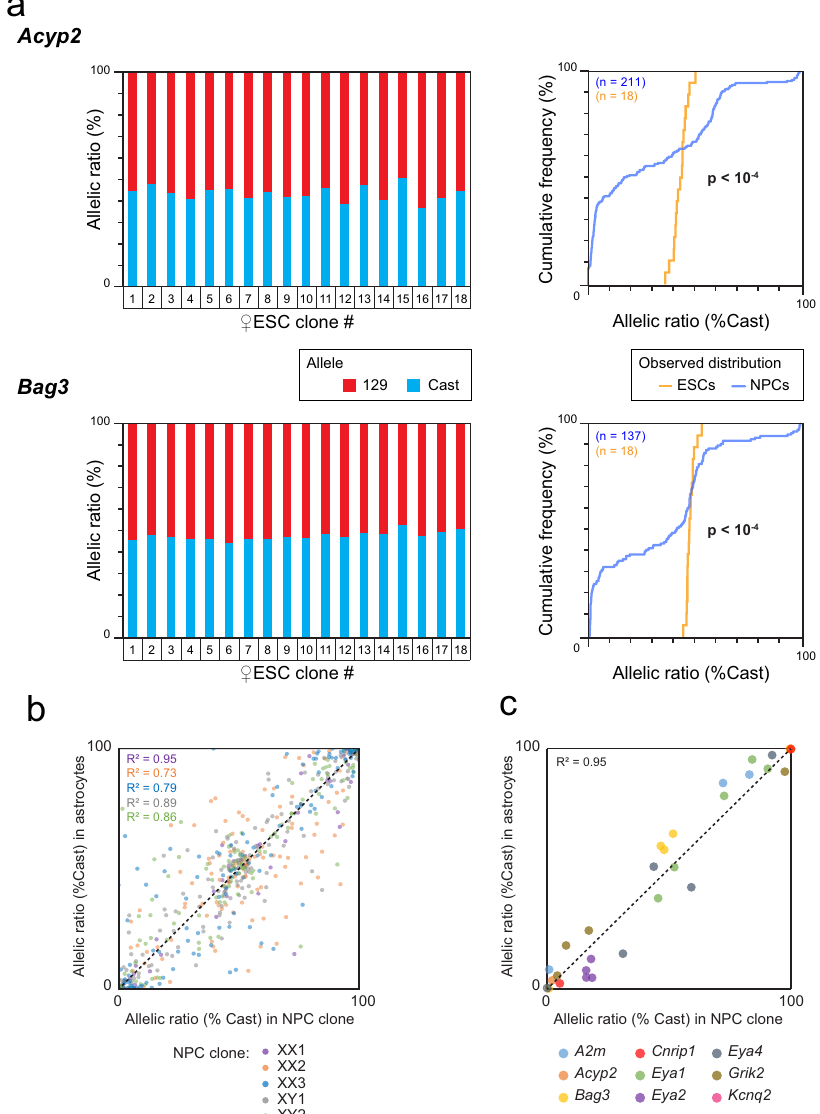
Fig. 3 Allele-speci fi c expression is established during differentiation and then maintained. a Analysis by RT-PCR followed by pyrosequencing of Acyp2 and Bag3 allelic expression ratio in 18 clones generated from the F1-21.6 ESC line (left panels). Comparison of the cumulative distributions of allelic expression ratios in ESCs and NPCs (Kolmogorov – Smirnov tests, right panels). n is the number of clones analyzed. b Comparison of the allelic expression ratios of the genes previously categorised as RME in NPCs 11 and after differentiation into astrocytes, for fi ve NPC clones, measured by allele-speci fi c RNA- seq. The number of assessable genes per clone (values with less than 20 reads were excluded) is n XX1 = 75, n XX2 = 146, n XX3 = 121, n XY1 = 150, n XY2 = 137. Pearson correlation coef fi cients were calculated for each NPC clone. c Comparison of the allelic expression ratio for the nine genes, which showed several modalities of expression, in fi ve NPC clones and after differentiation into RME genes Acyp2 , Bag3 and the biallelic gene Eya3 in all NPC clones. While the biallelic control Eya3 shows similar expression levels in all clones, Acyp2 and Bag3 could be divided in two main groups, showing either high or low expression levels (Fig. 5a).